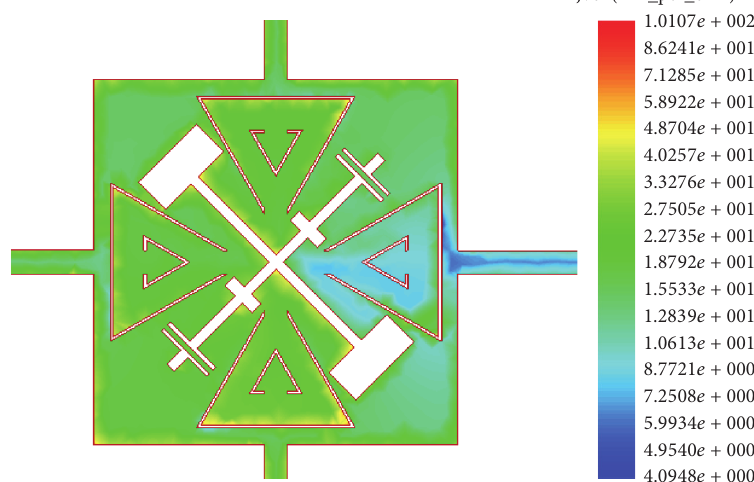
Figure 4: Current distribution of the coupler for 2.4 GHz.